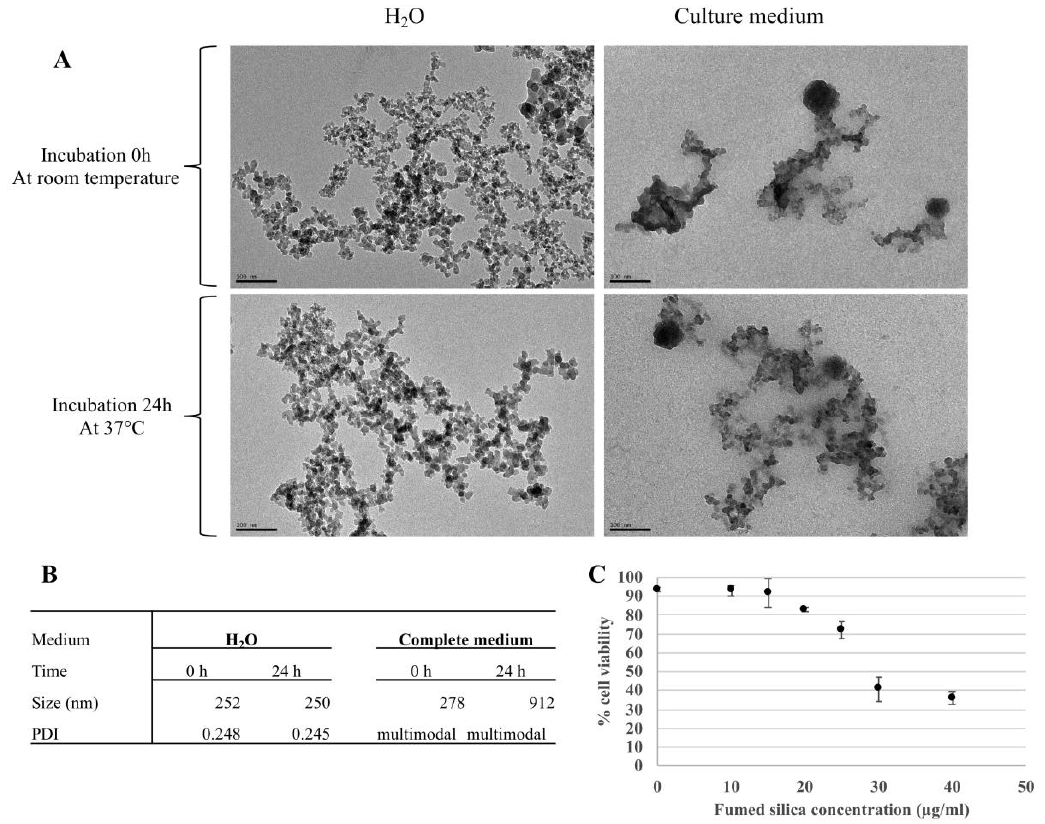
Figure 2. Pyrolytic silica characterization (by transmission electron microscope and dynamic light scattering) and cell viability with flow cytometer. ( A ) Observation by TEM. Nanoparticles were incubated in H 2 O (left) or culture medium (right) for either 0 h of incubation at room temperature (top) or 24 h of incubation at 37 ◦ C and 5% CO 2 (bottom). Scale bar = 100 nm. ( B ) Table Showing measures by DLS of the hydrodynamic diameter of nanoparticles in water and a culture medium at 0 and after 24 h of incubation. PDI: polydispersity percentage. ( C ) Cell viability of RAW264.7 exposed to fumed silica for 24 h using propidium iodide (1 μg/mL).